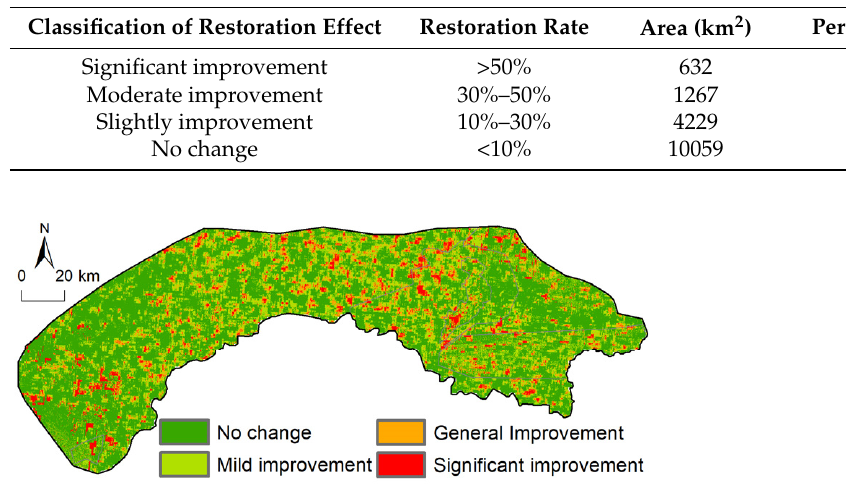
Table 4. Comprehensive evaluation table of ecological restoration in the Wuliangsuhai watershed.